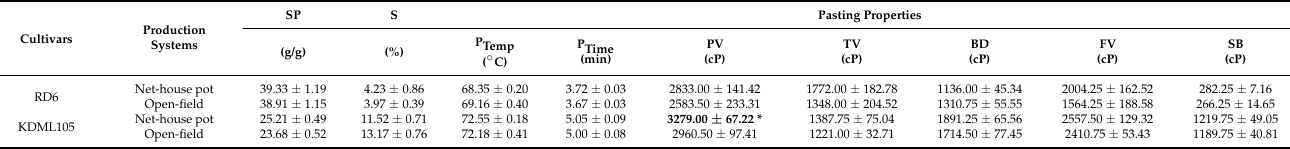
Values are means ± SEM. Means in bold within each column with the * symbol denote statistically significant difference between the two production systems at p ≤ 0.05 by Student’s t -test ( n = 4). Abbreviations: P Temp = pasting temperature; P Time = peak time; PV = peak viscosity; TV = trough viscosity; BD = breakdown; FV = final viscosity; and SB =